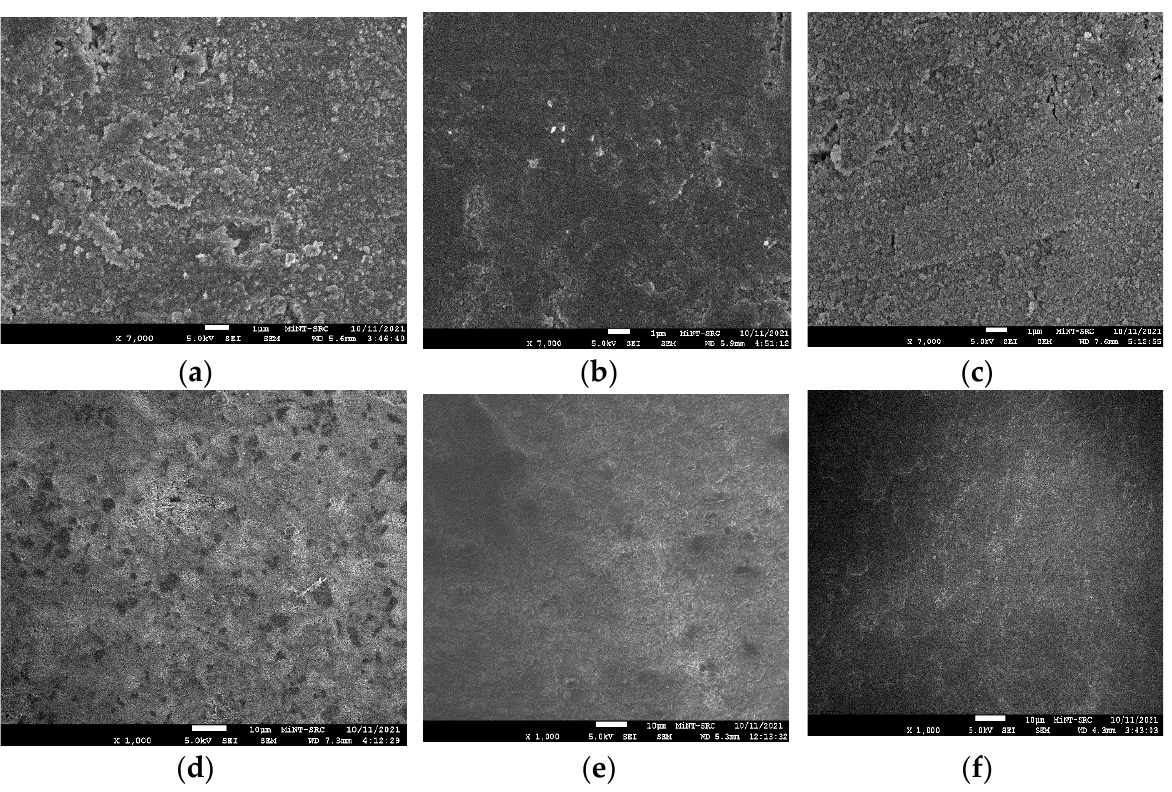
Figure 7. FE-SEM images of the investigated: ( a ) Al/5% B 4 C-5% ZrO 2 , ( b ) Al/15% B 4 C-15% ZrO 2 , ( c ) Al/10% B 4 C-10% ZrO 2 , ( d ) Al/5% B 4 C-15% ZrO 2 , ( e ) Al/15% B 4 C/5% ZrO 2 samples, and ( f ) Al-chips. Table 6. Effects of AFM mean area, volume, and length on surface roughness.